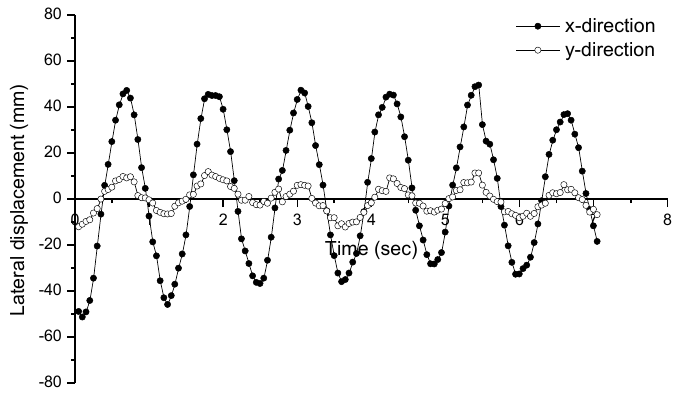
Figure 9. Displacement histories in both x- and y-directions measured by GPS.